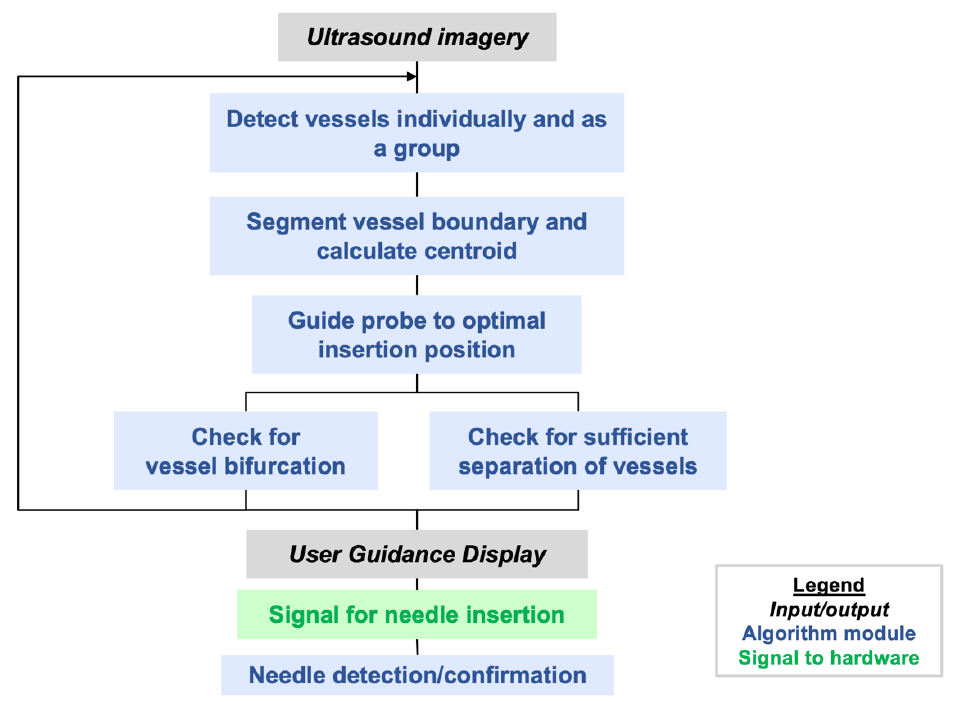
Figure 4. Flow diagram of informed AI for ultrasound-guided femoral vascular access.